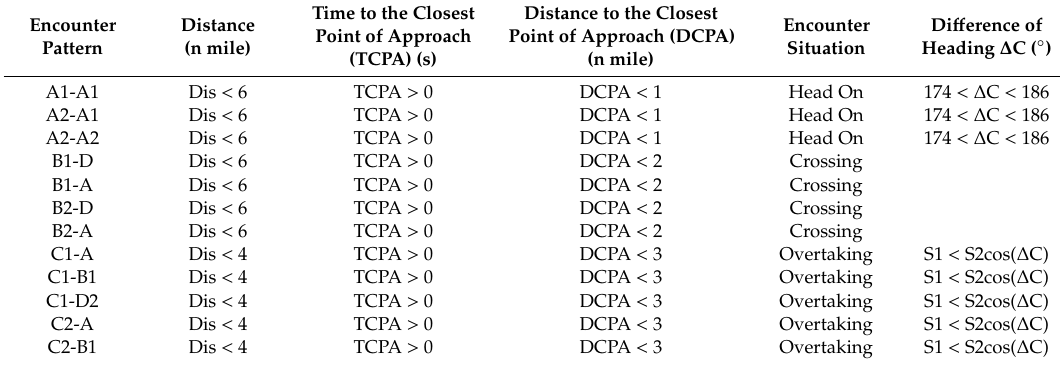
Table 1. Ship-encounter pattern class